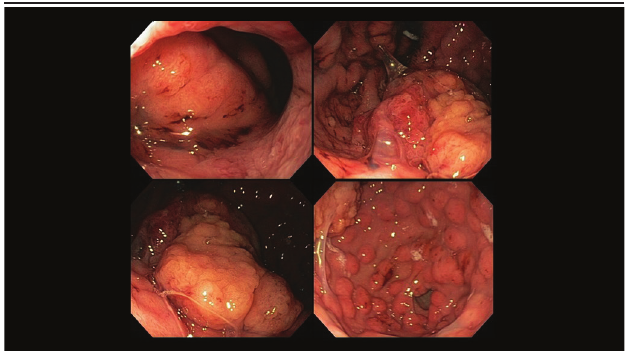
figurE 1 − Overview of the body and fundus of the stomach, with hypertrophy of gastric folds, mucosal congestion and swelling, with presence of mucus